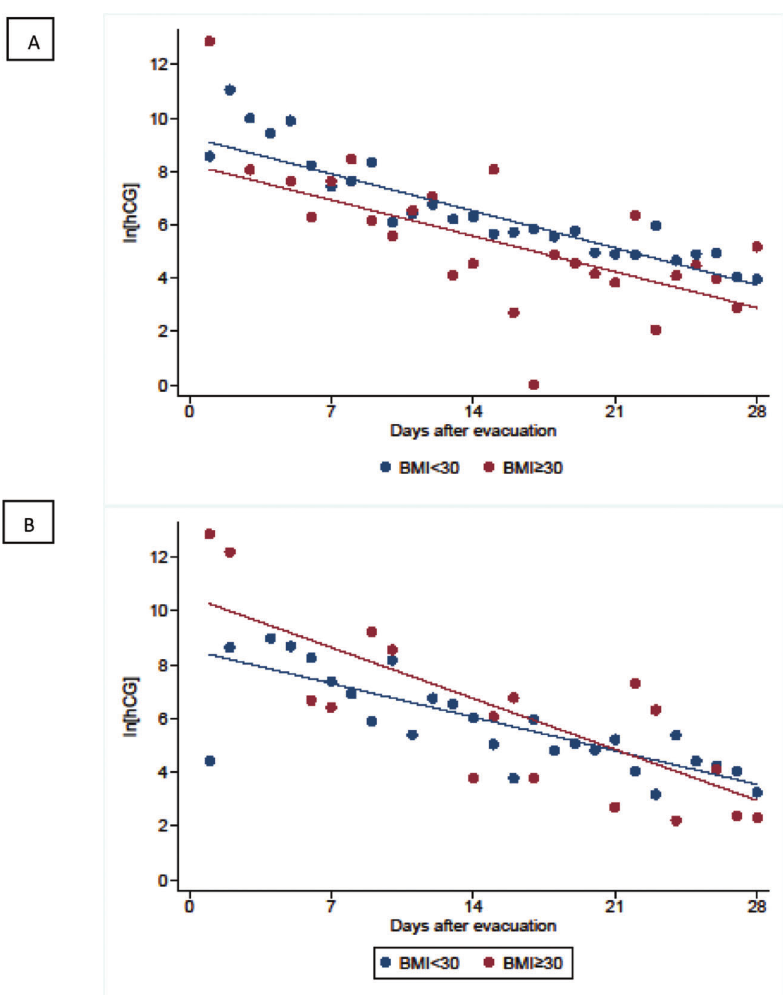
Figure S3 - Human gonadotropin (hCG) regression curves by body mass index (BMI) for (A) complete and (B) partial molar pregnancies. Each point represents the mean hCG level. The rate of hCG regression was significantly higher among patients with obesity (BMI X 30 kg/m 2 ) than in those without obesity ( p =0.02). This difference was significant among women with partial molar pregnancies ( p =0.03), but not among women with complete molar pregnancies ( p =0.19).